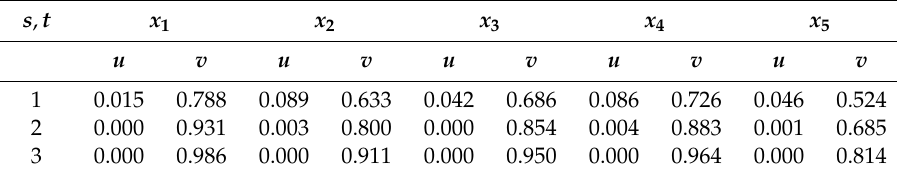
Table 3. The comprehensive attribute value of each scheme based on q-ROF Bonferroni mean (q-ROFBM)